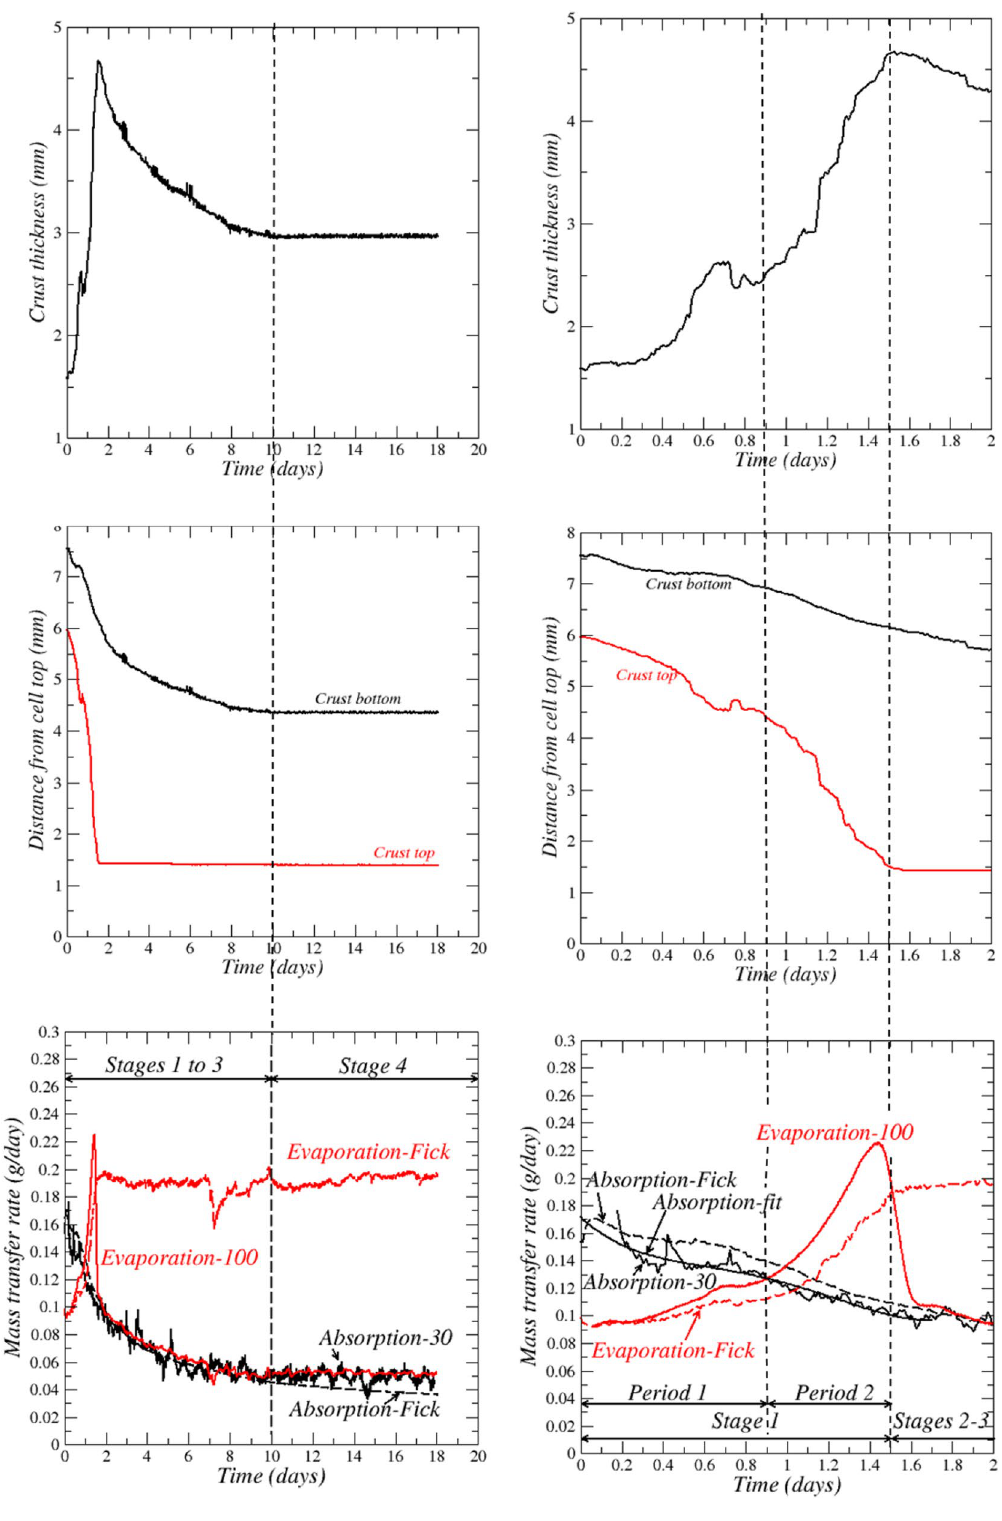
Figure 3. Evolution of salt crust thickness, crust top and bottom surfaces mean positions, potential evaporation (“Evaporation–Fick”), absorption and evaporation rates. The solid curves labelled “Absorption-30”, “Absorption- Fit” and “Evaporation-100” correspond to measurements (see the “Materials and Methods” section for details on how these curves are obtained). The dashed curves labelled “Evaporation-Fick” and “Absorption-Fick” are determined from Fick’s law (see text). The figures in the right column are a zoom over the experiment first two